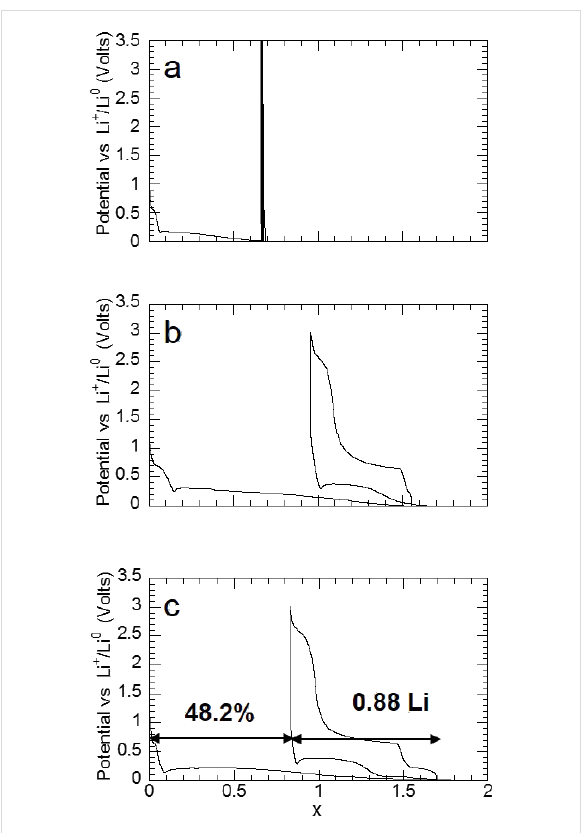
Figure 14: Evolution of the potential (V) as a function of x (mole frac- tion of Li) for MgH 2 electrodes cycled between 3 and 0.005 V at a rate of one equivalent of lithium in 10 h. a) MgH 2 commercial hydride; b) MgH 2 obtained after one absorption of hydrogen; c) MgH 2 obtained after three absorptions of hydrogen